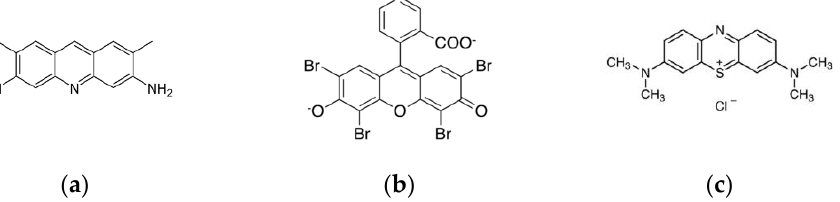
Figure 2. Structural formulas of dyes employed in the work to create the fluorescent probe array: ( a ) acridine yellow ( φ = 0.47, λ ex = 445 nm, λ em = 505 nm), ( b ) eosin ( φ = 0.67, λ ex = 500 nm, λ em = 545 nm), and ( c ) methylene blue ( φ = 0.52, λ ex = 660 nm, λ em = 680).